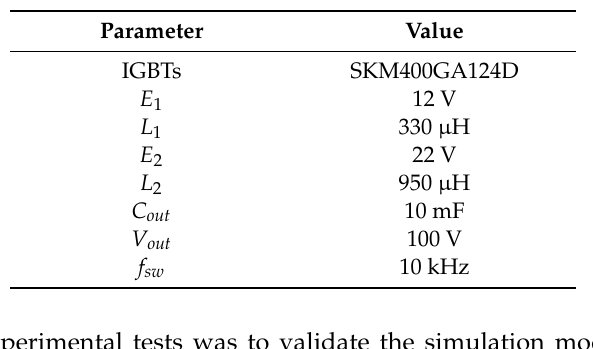
Table 2. Prototype